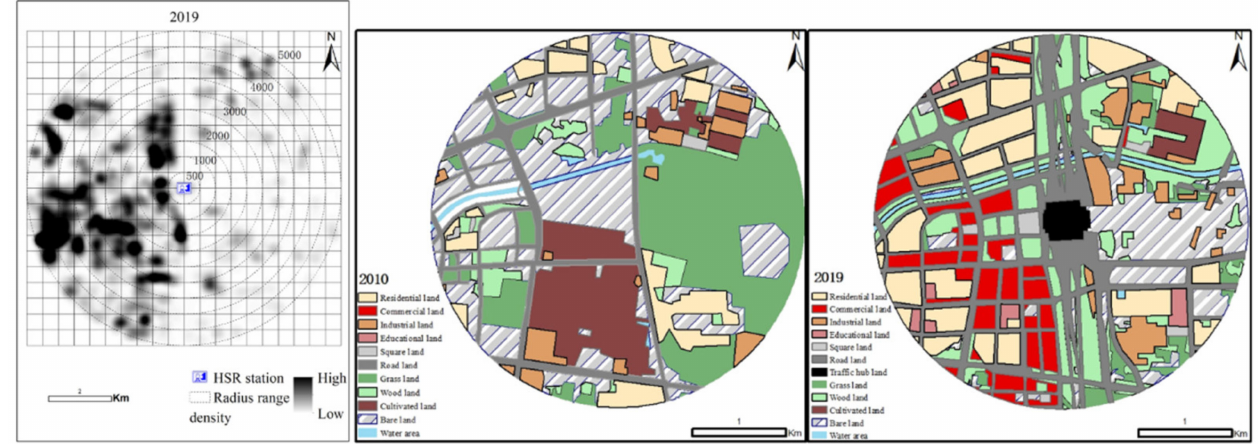
Figure 1. Kernel density and land use of Zhengzhou East railway